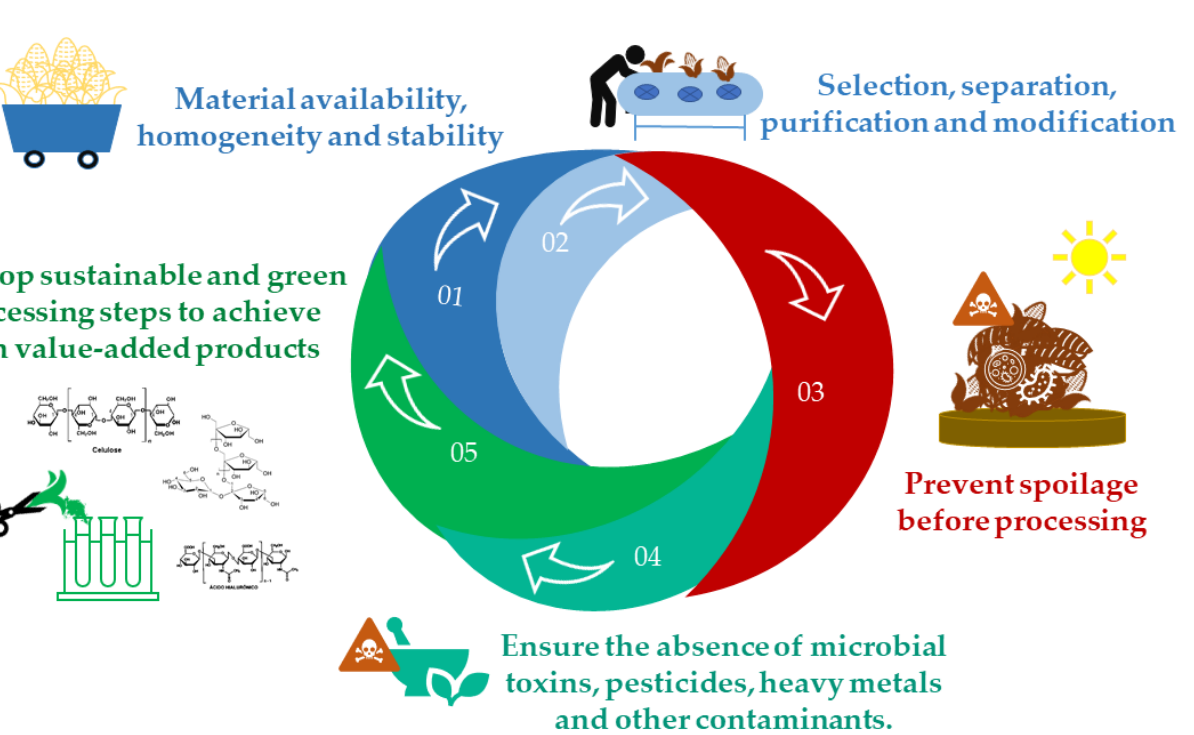
Figure 2. Summary of some challenges to be overcome for the utilization of